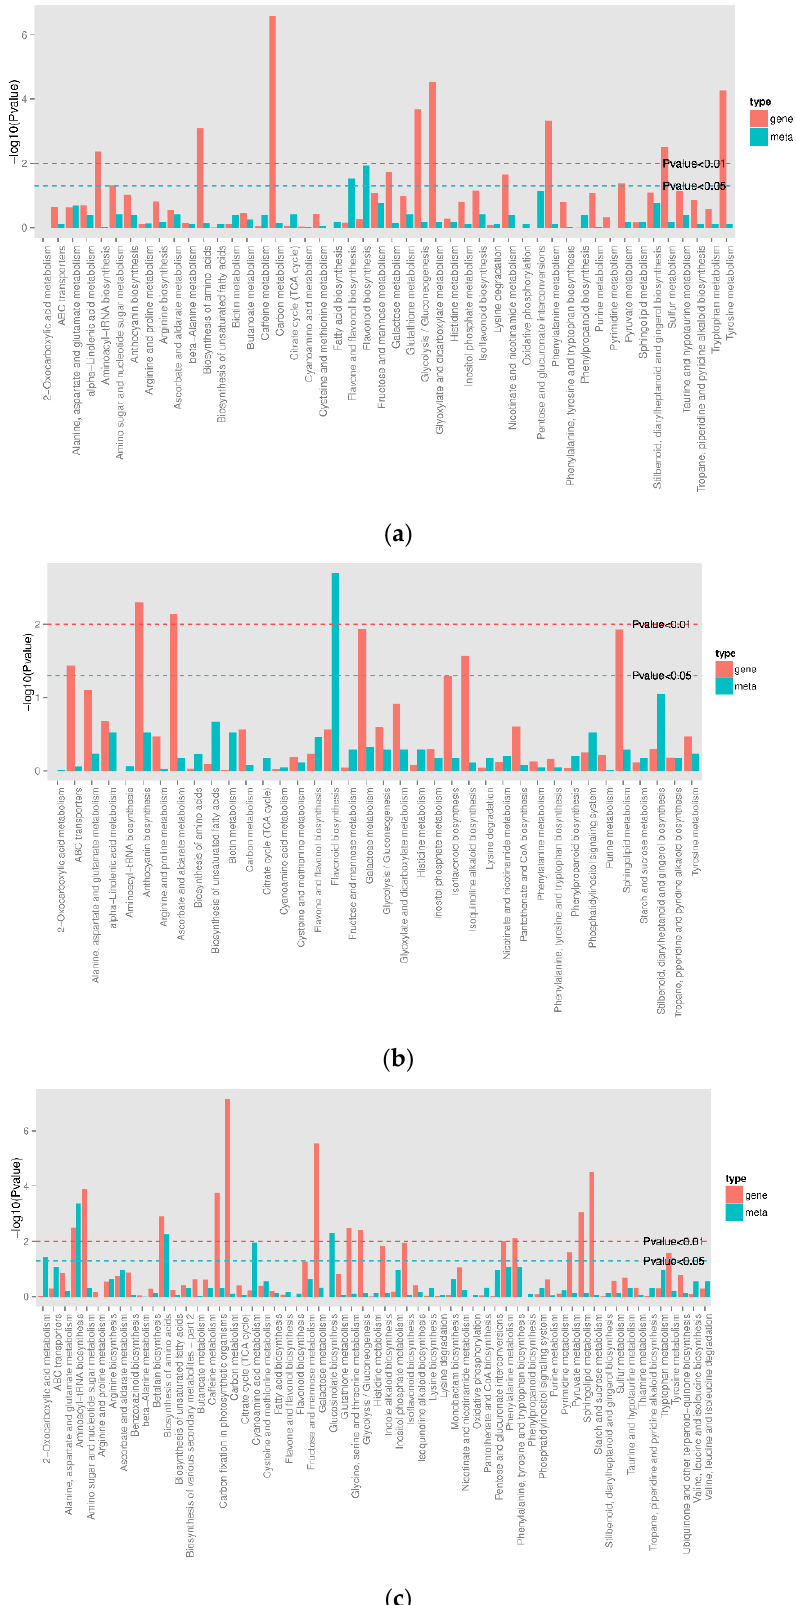
Figure 12. Column diagrams of differential metabolite and differential gene co-enrichment. ( a ) mRO vs. mLO; ( b ) mRO vs. mSO; ( c ) mSO vs. mLO.